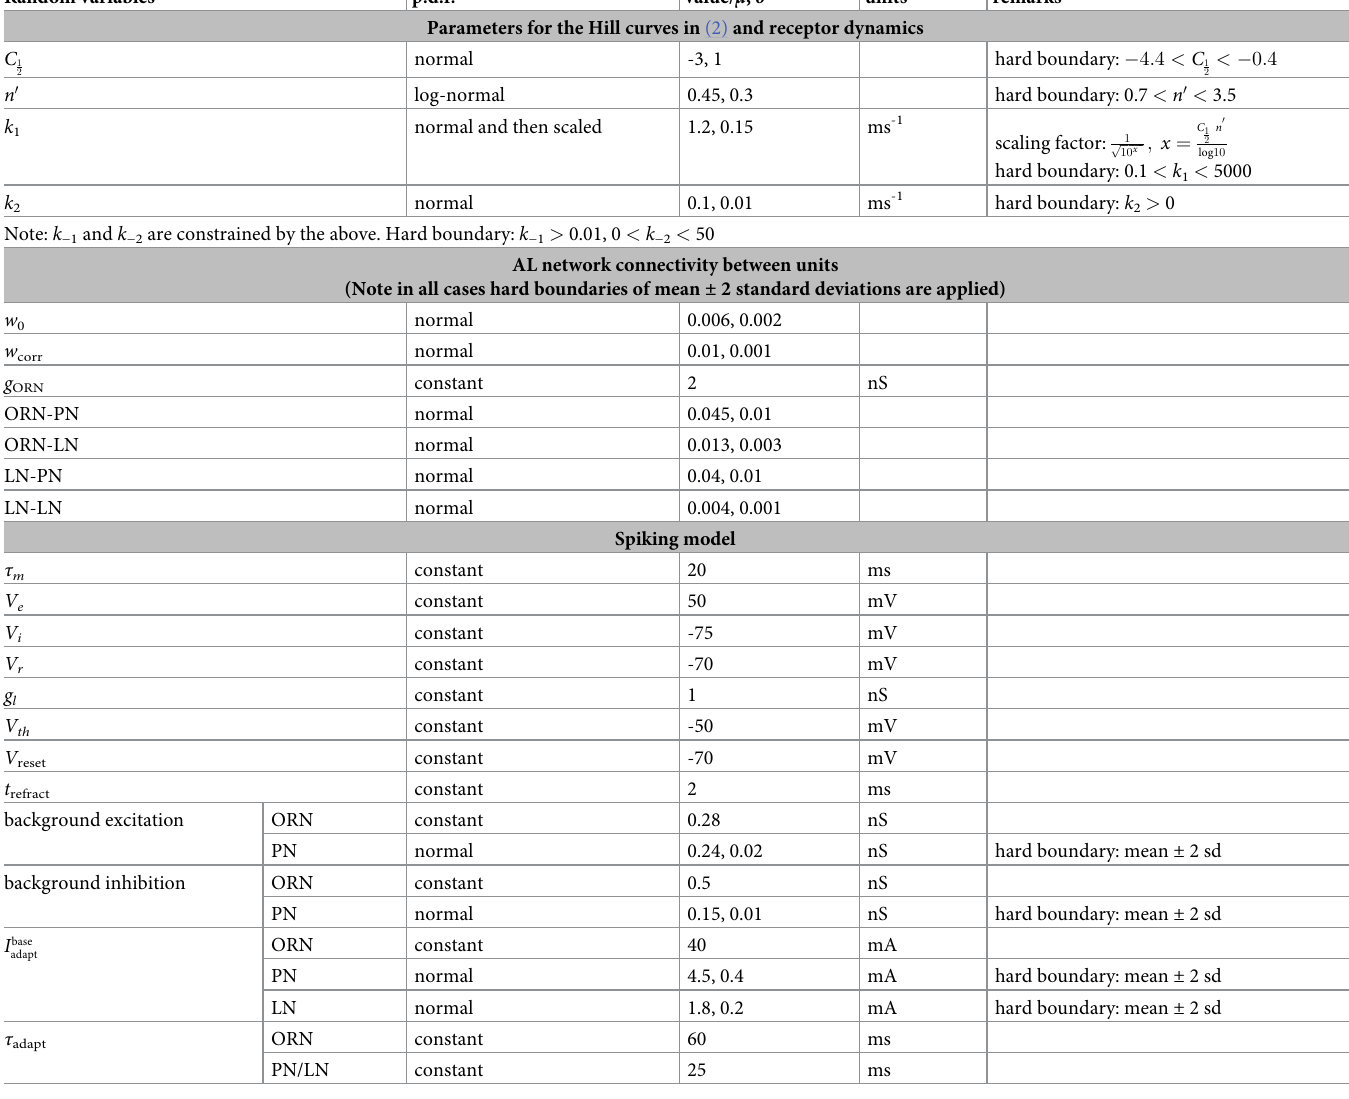
Table 2. Parameters used in the AL model. Random